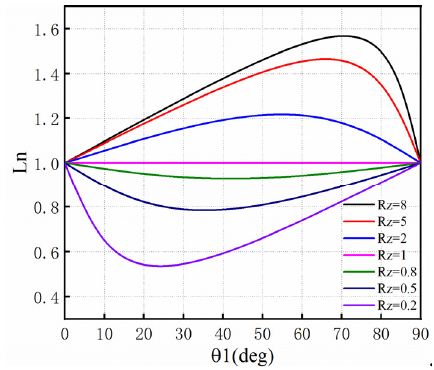
Figure 3. Resonance conditions of SIR.